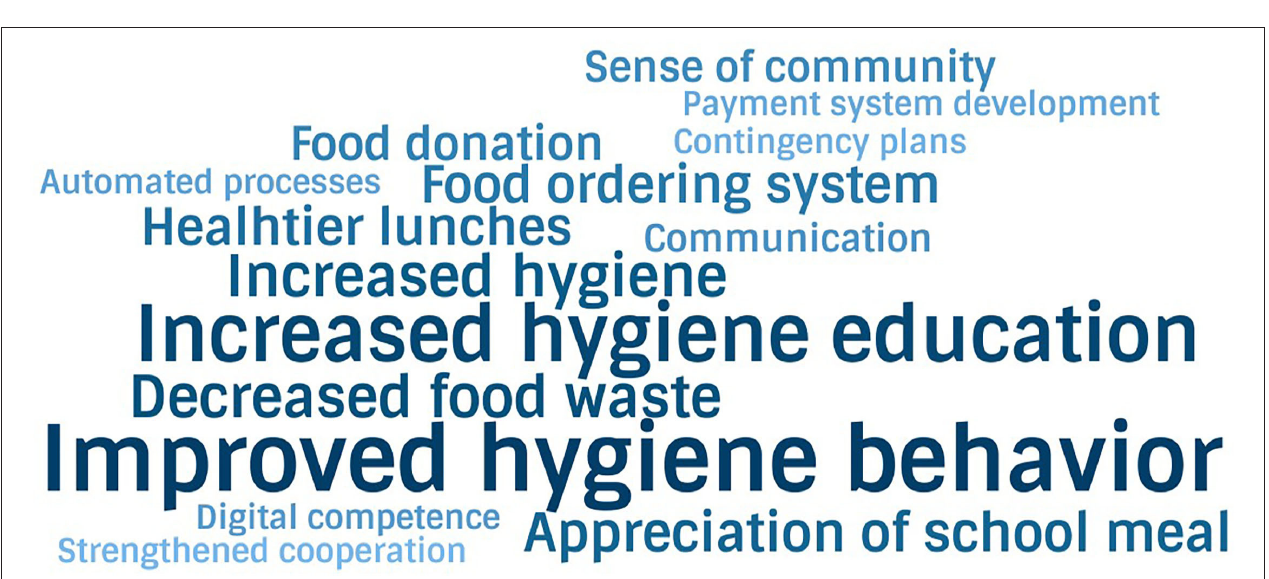
FIGURE 4 | A word cloud for the reported BSR challenges and problems. Source: own analysis based on interviews.